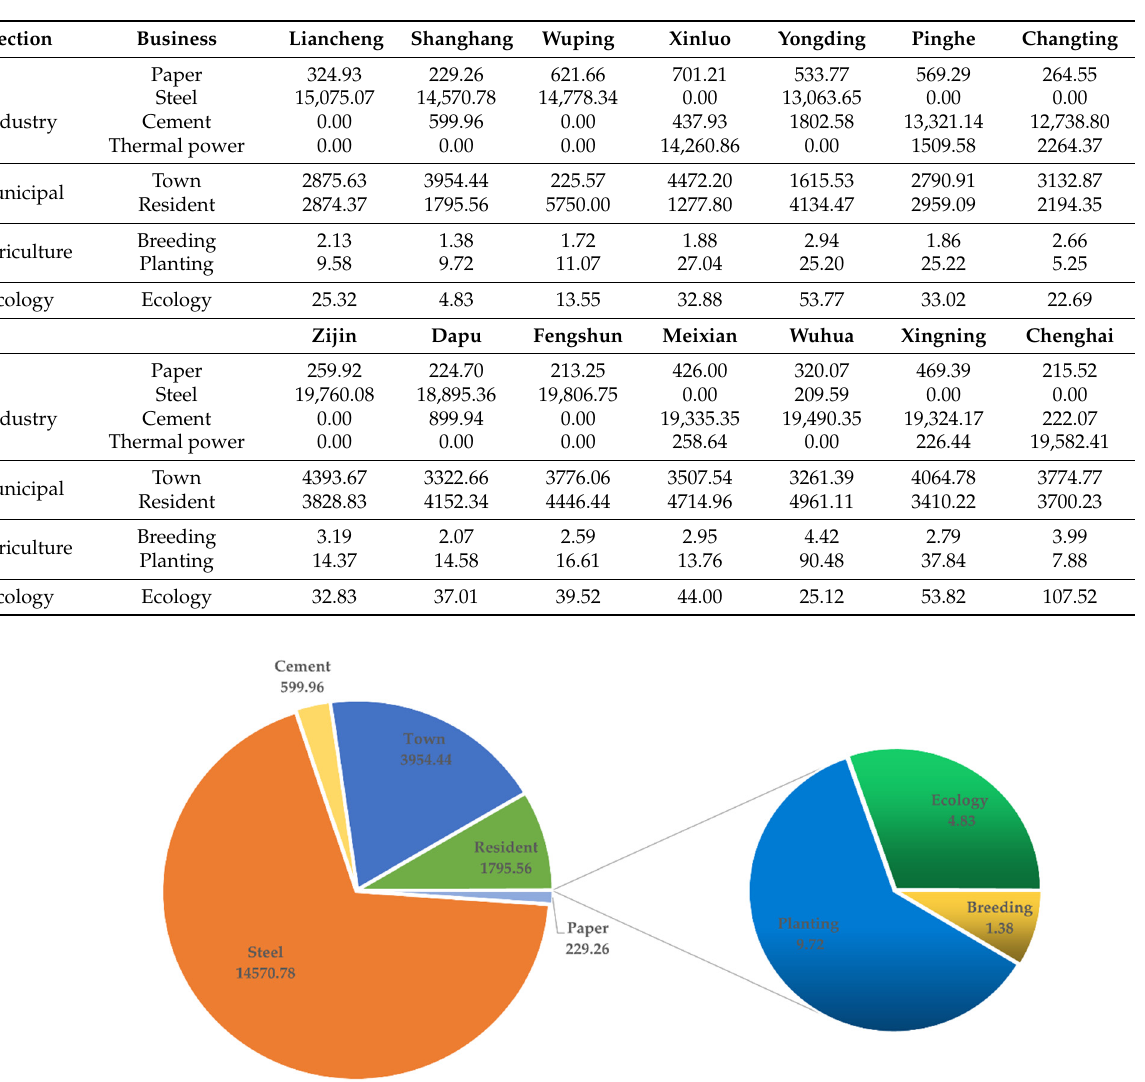
Table 1. Optimized allocation of water resources utilization of different water consumption sectors in each administrative unit in the upper and lower reaches of Tingjiang River based on the IFTS model in the first stage ( × 10 4 t).